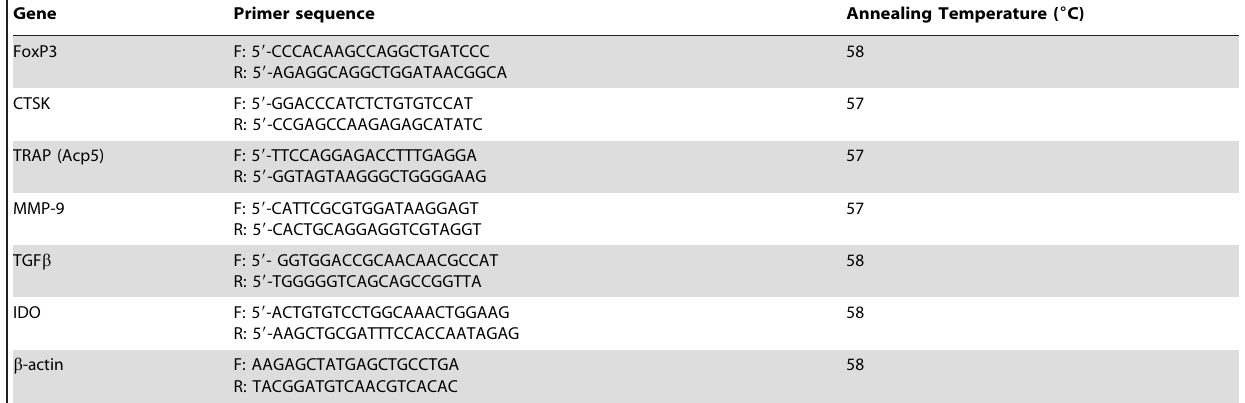
Table 1. Primers used for